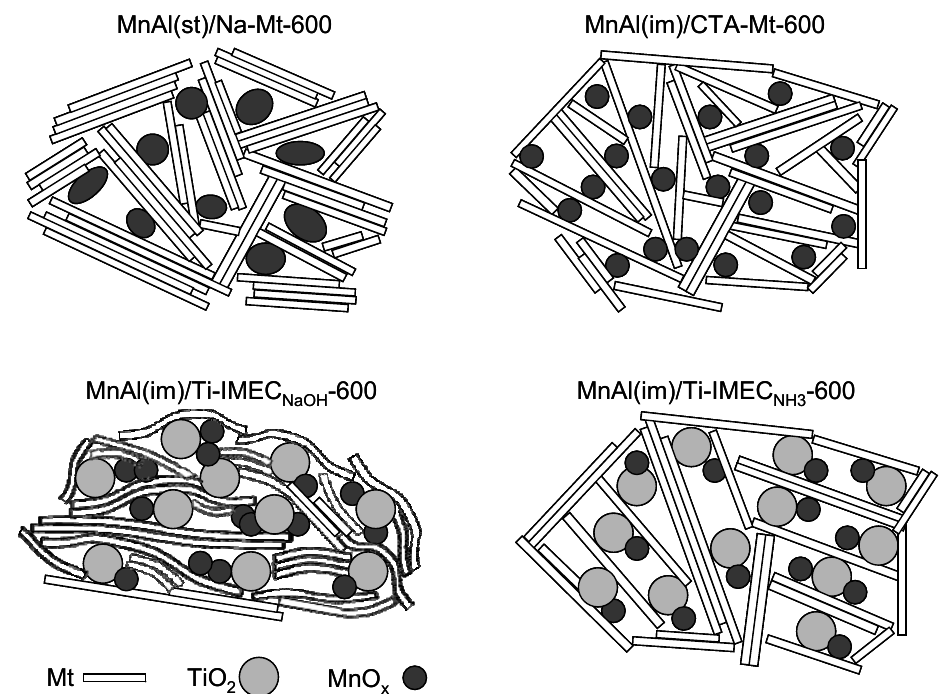
Figure 6. Schematic models of investigated composites calcined at 600 °C.